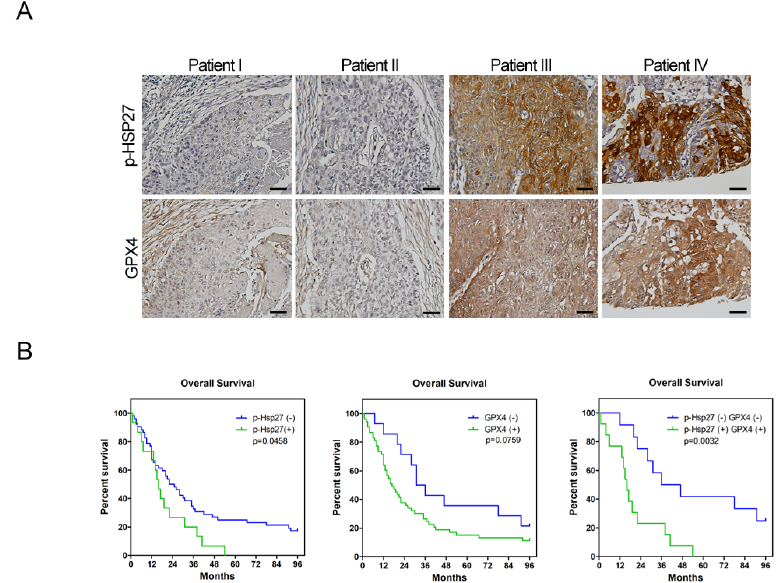
Figure 5. Phospho-Hsp27-GPX4 expression is correlated with prognosis in esophageal cancer pa- tients. ( A ) Immunohistochemical staining of phospho-Hsp27 and GPX4 in patients with esophageal squamous cells carcinoma. ( B ) The survival curves of esophageal cancer patients with or without upregulated phospho-Hsp27 and GPX4 expression (calculated using the Kaplan–Meier method). Expression of phospho-Hsp27 or GPX4 of ≥ 30% was regarded as positive. Scale bars, 50 μ m.